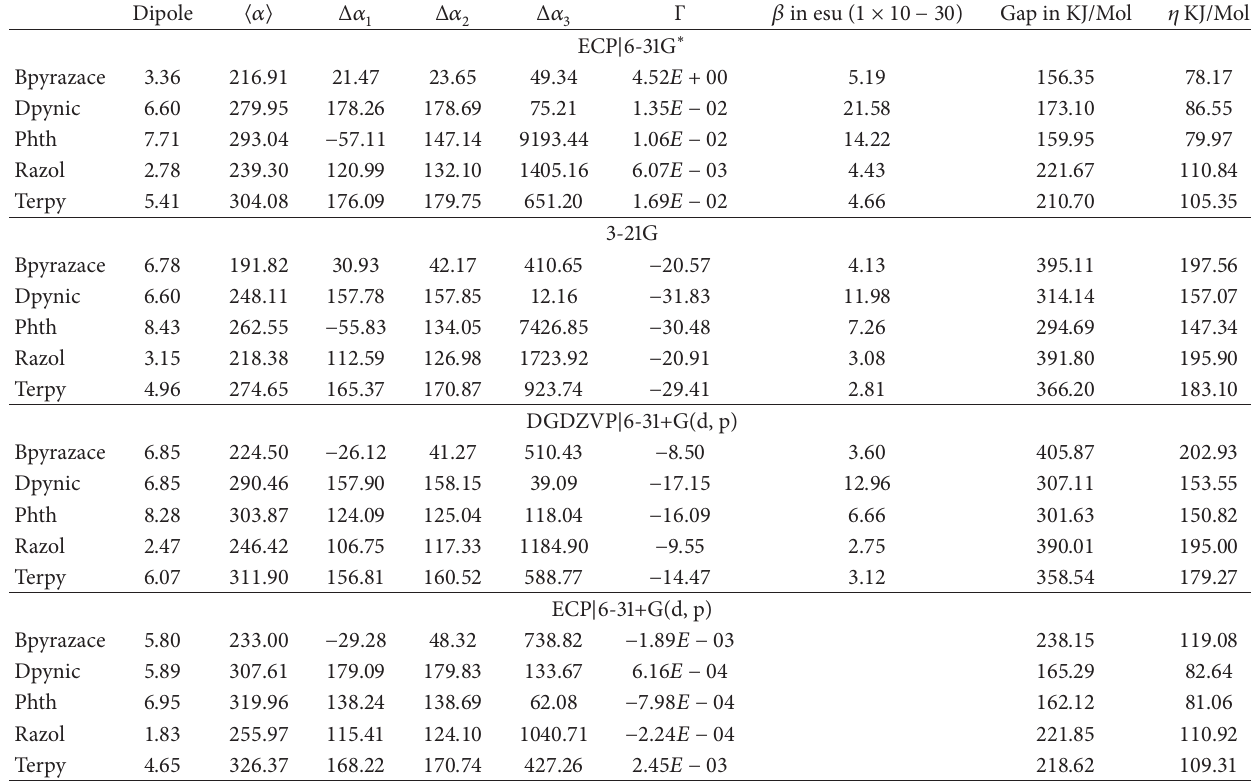
Table 6: The conductive properties of the